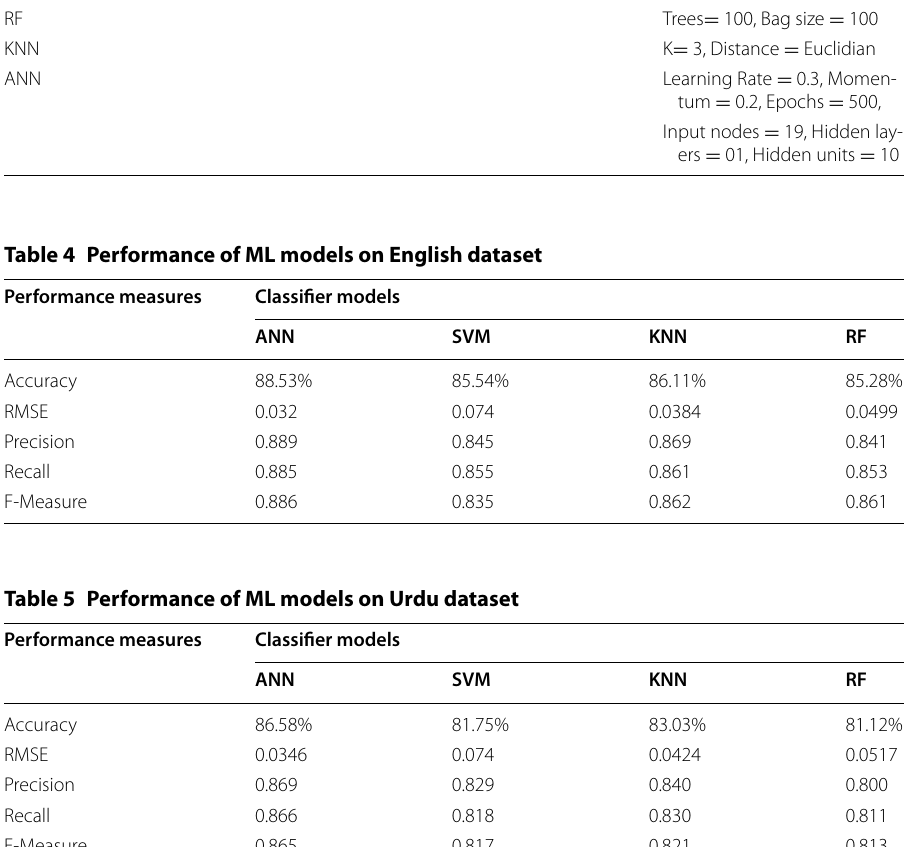
Table 3 Design parameters of ML classifiers ML Models